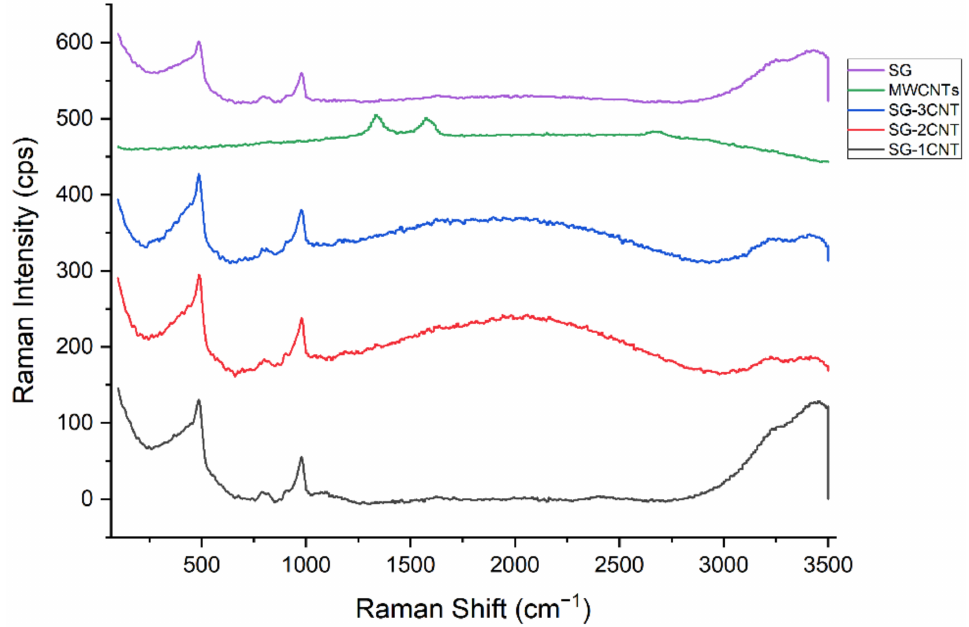
Figure 9. Raman spectra were acquired from original control samples of silica gel and MWCNTs, and three composites of both: SG-1CNT (0.25 wt%), SG-2CNT (0.50 wt%), and SG-3CNT (0.75